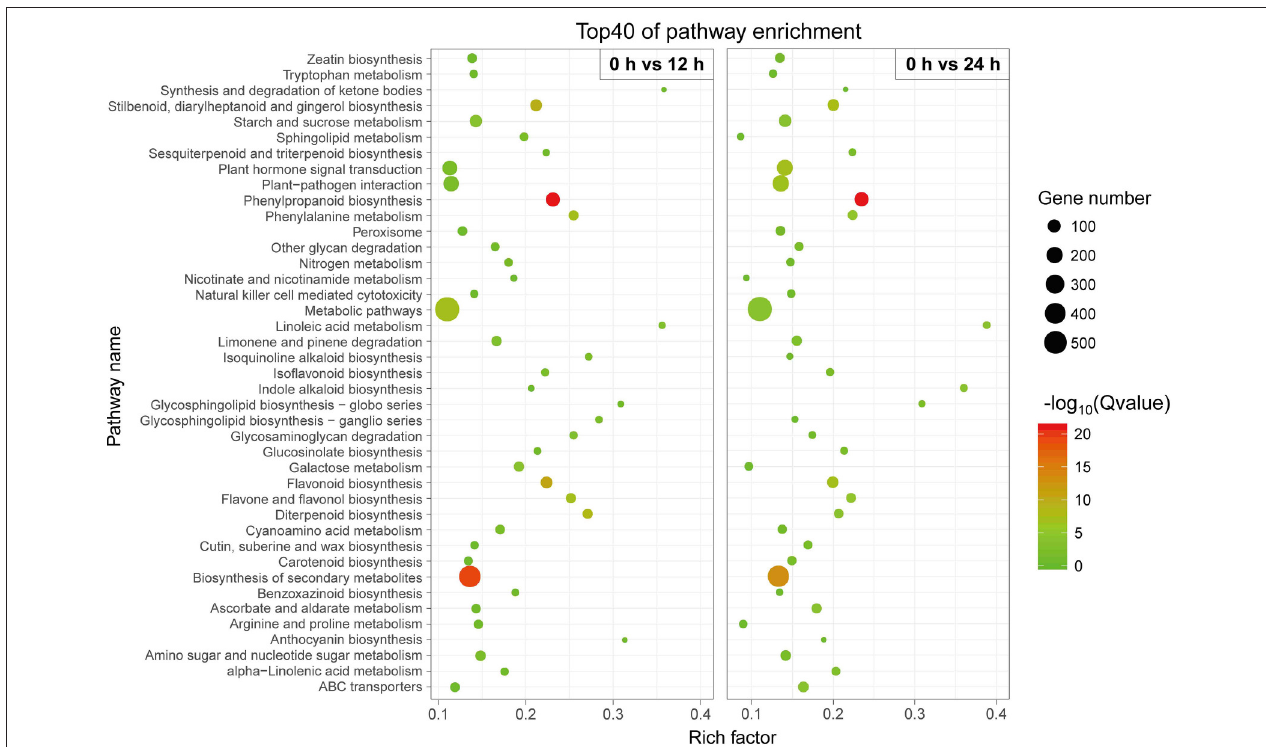
FIGURE 4 | Top 40 enriched KEGG pathways among the annotated DEGs across two comparisons. The Y -axis on the left represents KEGG pathways, and the X -axis indicates the enrichment factor. Low q -values are shown in green, and high q -values are depicted in